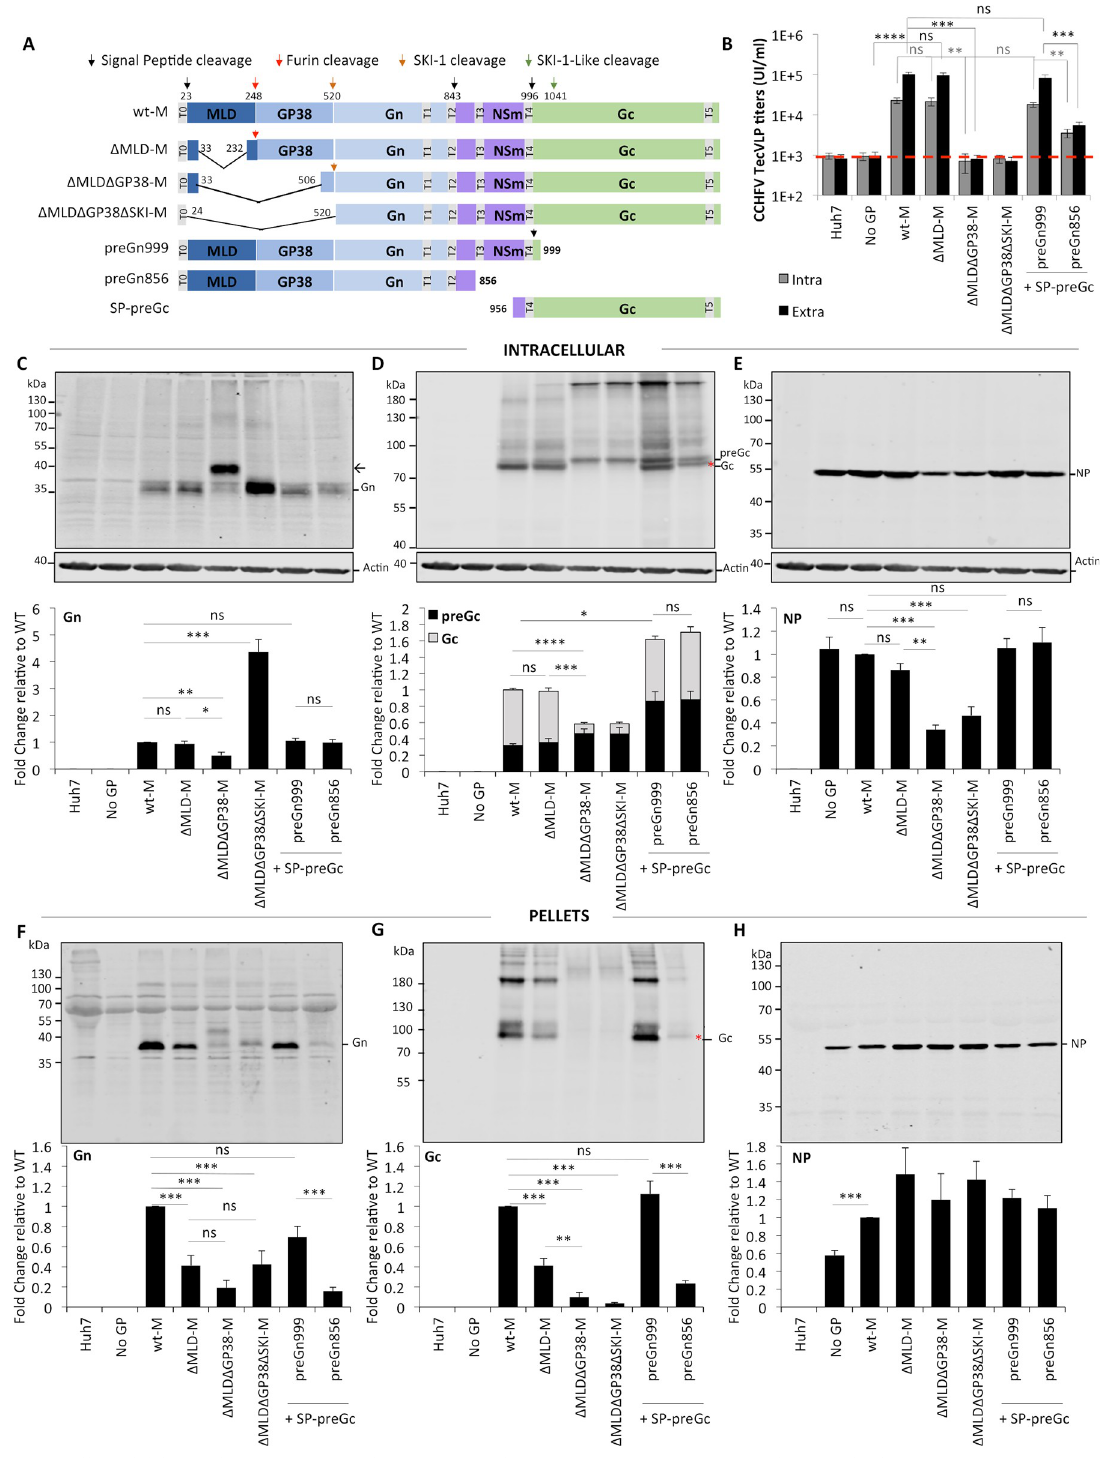
Fig 1. Effect of deleting the MLD, GP38 and NSm proteins from CCHFV M-segment on production of infectious CCHFV tc-VLPs. ( A ) Schematic representation of the polyproteins encoded by CCHFV wt-M cDNA and mutant cDNA clones: three internal deletion mutants ( Δ MLD-M, Δ MLD Δ GP38-M and Δ MLD Δ GP38 Δ SKI-M), two C-terminal truncation mutants (preGn999 and preGn856) and one N-terminal deletion mutant (SP-preGc). The polyprotein precursor organization and positions of the first amino-acid residues after cleavage marking protein boundaries (MLD, GP38, Gn, NSm, and Gc) within the CCHFV polyprotein are shown. The N-terminal signal